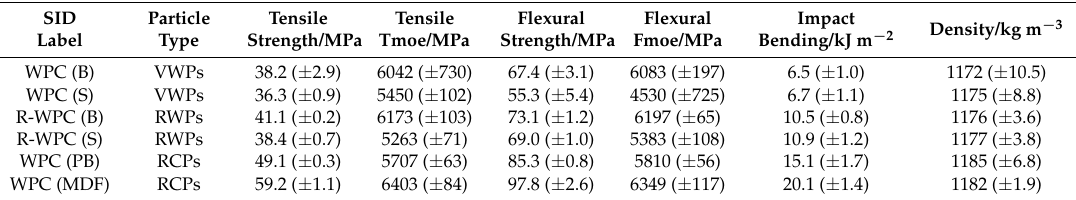
Table 4. Physico-mechanical properties of injection moulded specimens of reinforced PP composites using various particle sources. Particle types: VWPs (virgin wood particles), RWPs (reprocessed WPC particles), RCPs (recycled composite